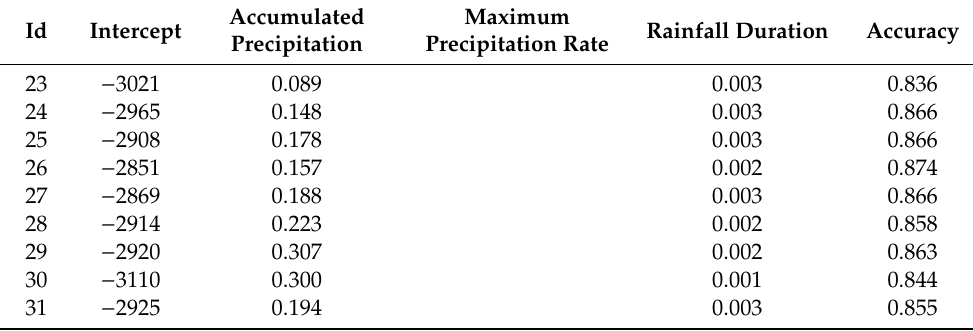
TableA3. Logisticregressionmodelcoe ffi cientsforthetwovariablesincludedaccumulatedprecipitation and a maximum precipitation